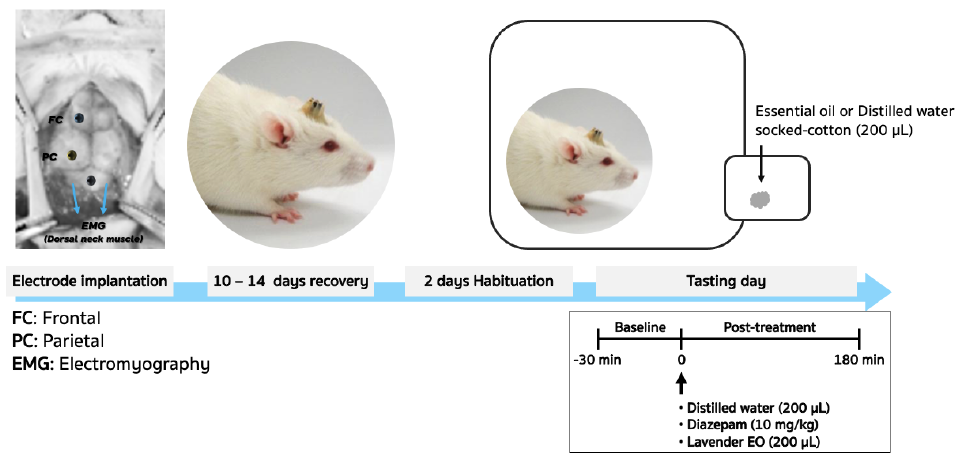
Figure 1. From animal surgery to experimental setup for EEG recordings, a schematic